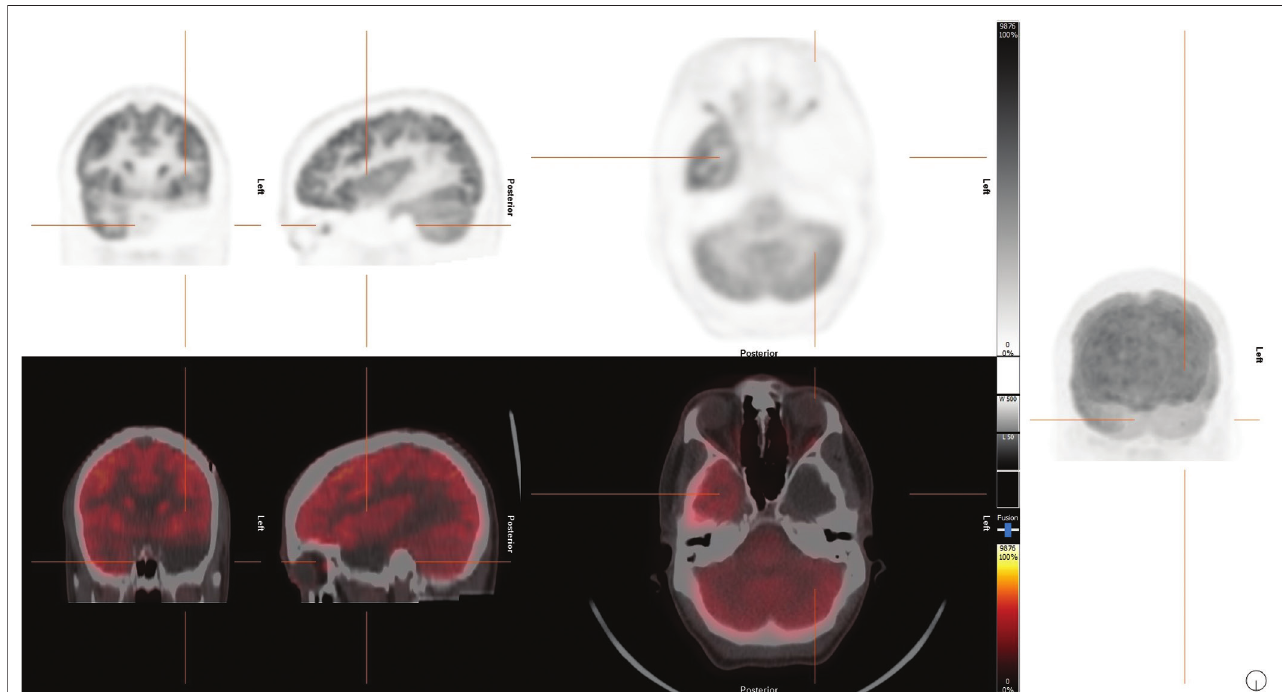
FIGURE 5: Interictal FDG PET scan in a patient with intractable temporal lobe epilepsy being worked up for epilepsy surgery. The scan demonstrates marked hypometabolism in the left temporal lobe, confirming lateralisation of the epileptogenic focus. The right panel demonstrates the PET maximum intensity projection; top row - PET orthogonal slices; bottom row - fused (PET-CT) orthogonal